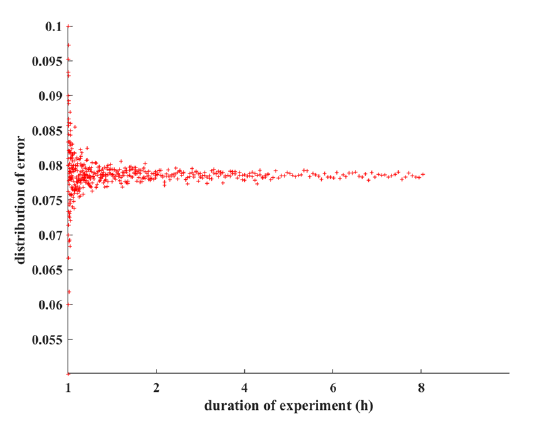
Figure 7. Distribution of error from the experiments on delivery ratio comparison.